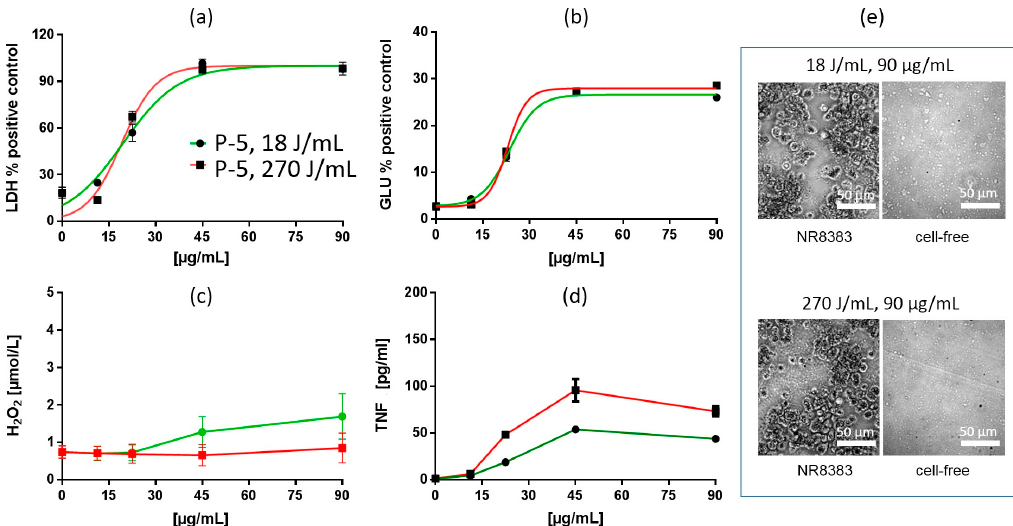
Figure 2. In vitro response of NR8383 alveolar macrophages to precipitated silica P-5. Particles were dispersed with either 18 J/mL (green) or 270 J/mL (red). ( a ) lactate dehydrogenase activity (LDH), ( b ) glucuronidase activity (GLU), ( c ) H 2 O 2 concentration, and ( d ) tumor necrosis factor alpha (TNF). ( e ) NR8383 cells after 16 h exposure to P-5, dispersed with 18 J/mL or 270 J/mL; right panels show particles settled onto the bottom of culture well under cell-free conditions. P-5-treated cells appear deteriorated and particles are visible between cells were. Note that settled P-5 particles dispersed with 270 J/mL appear smaller than particles dispersed with 18 J/ml.